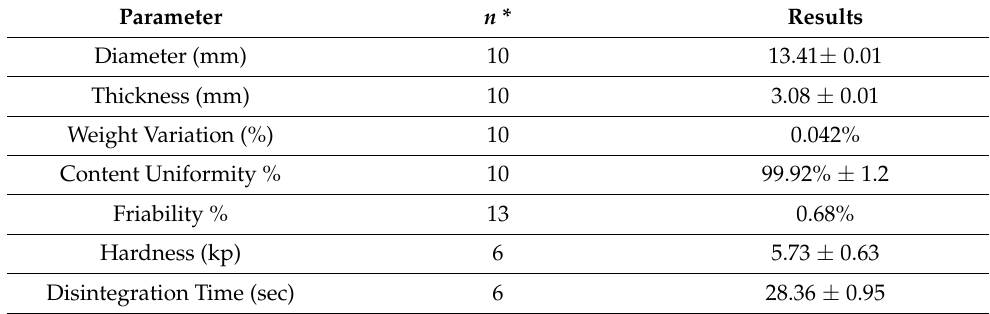
Table 8. Quality parameters of PGZ orally disintegrating tablets (ODT).